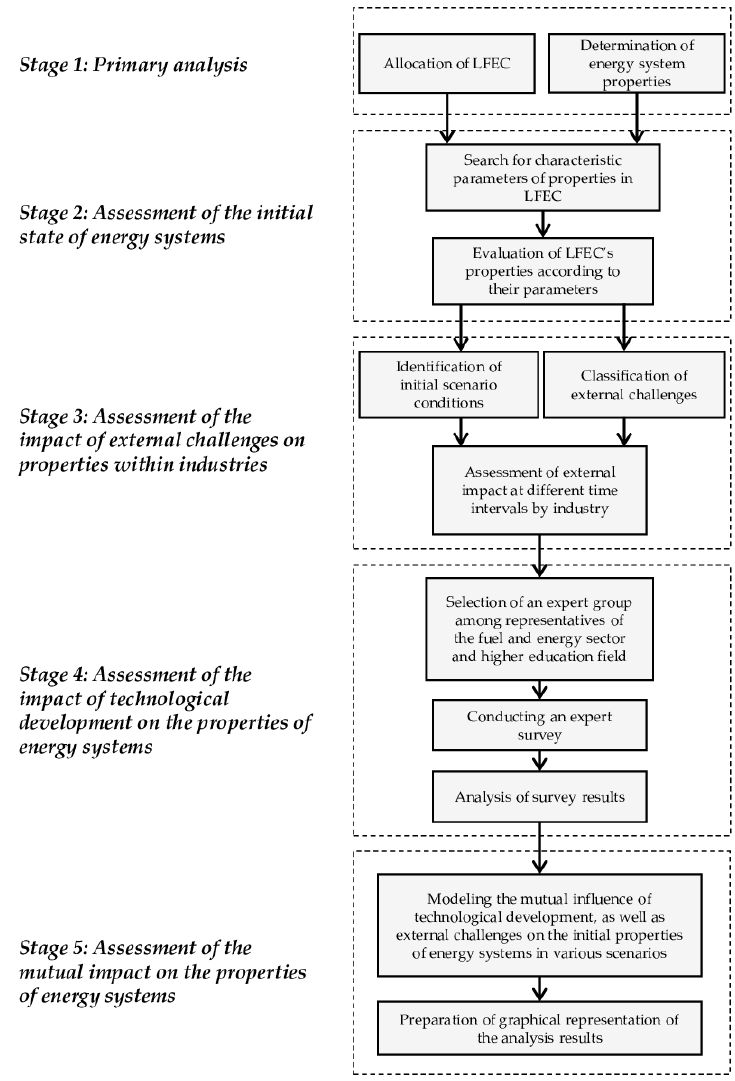
Figure 2. Research methodology.